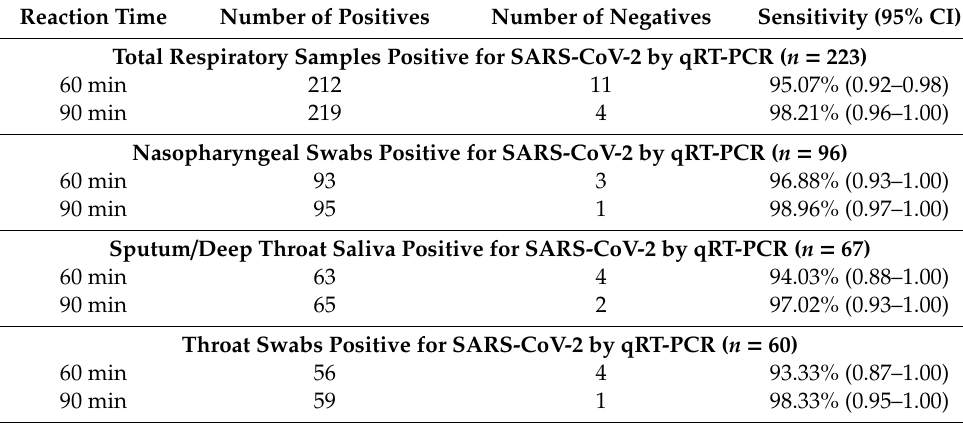
Table 2. Evaluation of COVID-19-LAMP using respiratory samples confirmed positive for SARS-CoV-2 by qRT-PCR ( n =